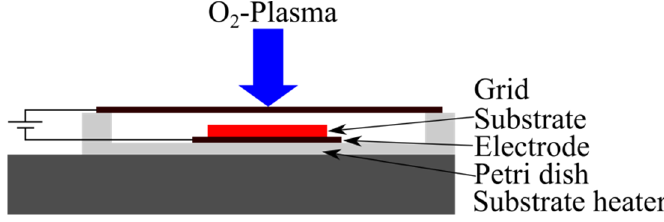
Figure 2. DC BIAS configuration in the reaction chamber.